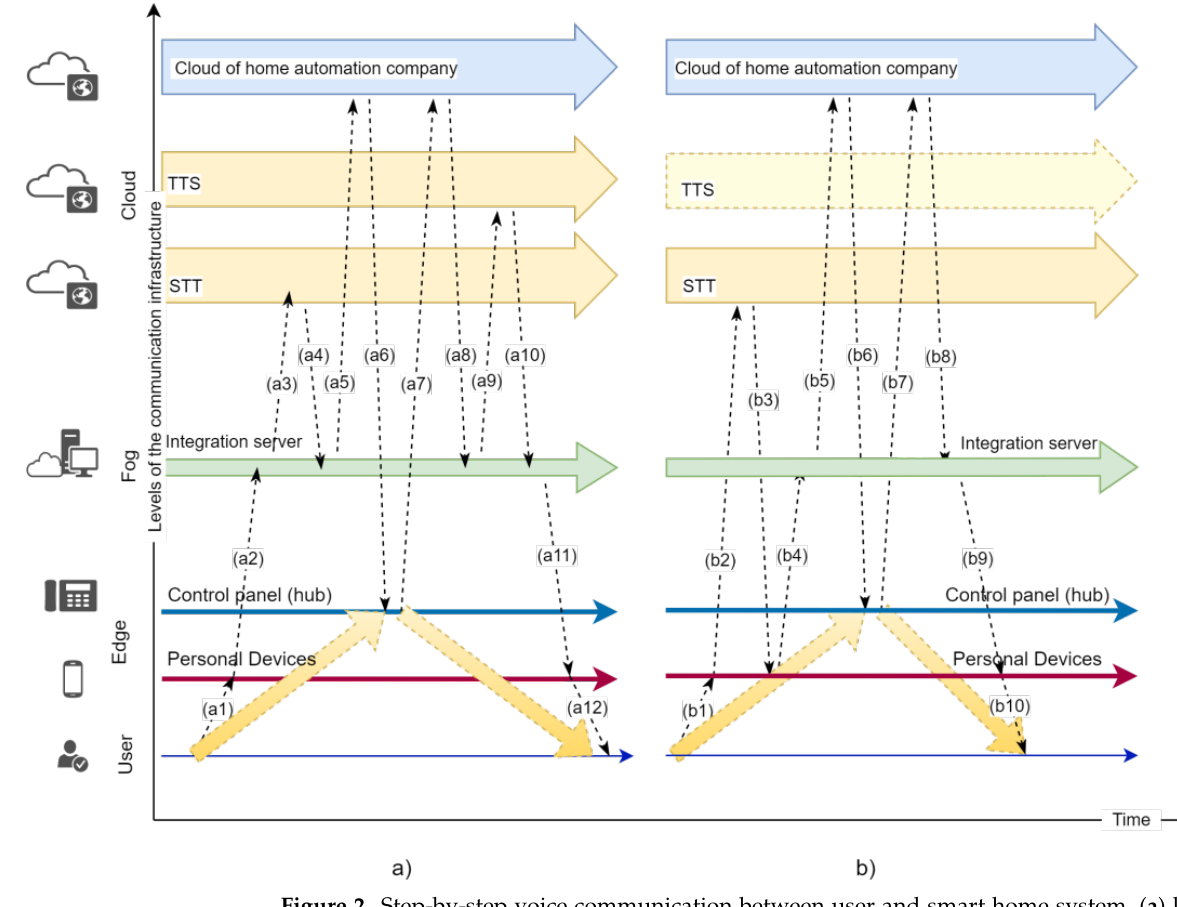
Figure 2. Step-by-step voice communication between user and smart home system, ( a ) long and ( b ) short version, respectively. Algorithm 1 User – smart home system interactions via speech command as a part of SUI